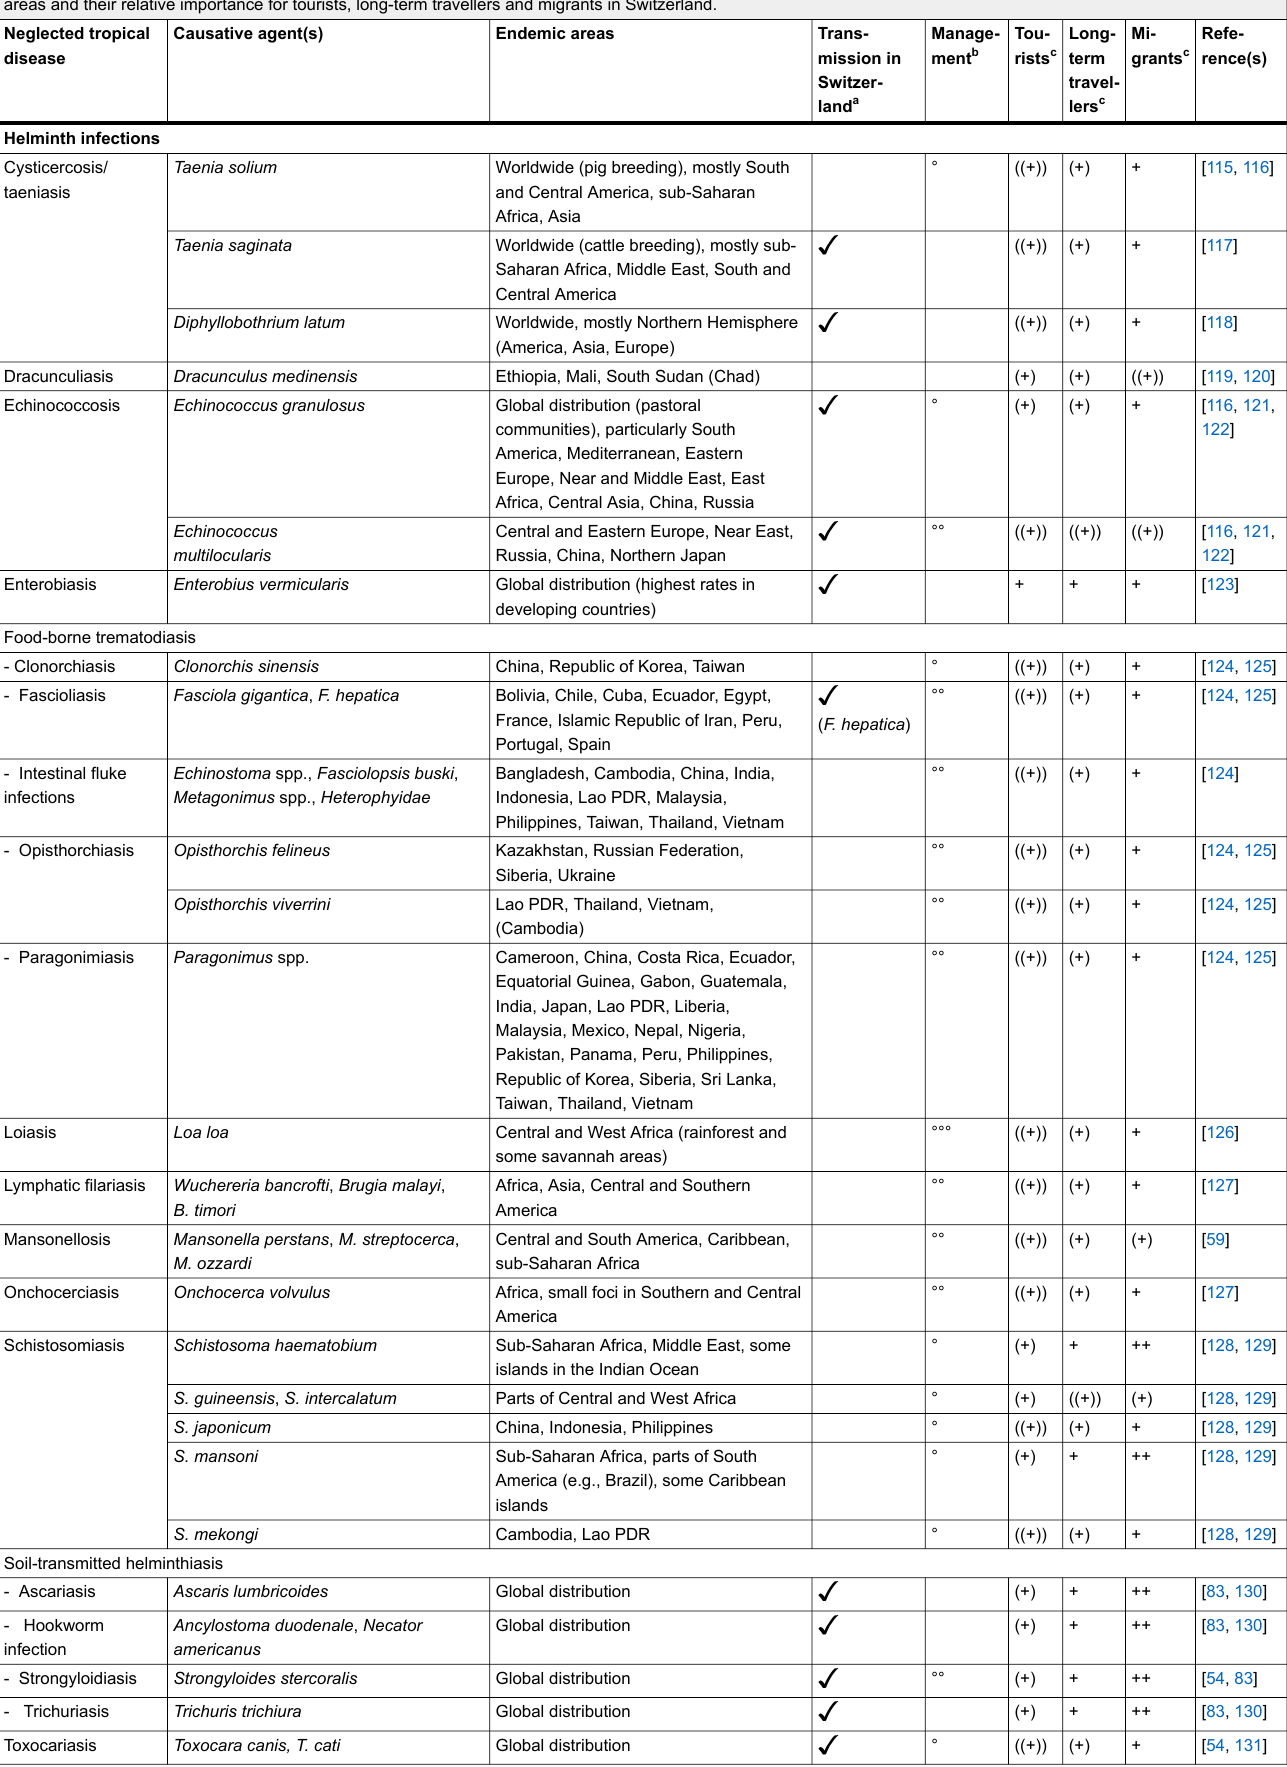
Table 1: Neglected tropical diseases, stratified by helminthic, protozoal, bacterial, fungal, viral and ectoparasitic infections, including causative agents, current endemic areas and their relative importance for tourists, long-term travellers and migrants in Switzerland. Neglected tropical